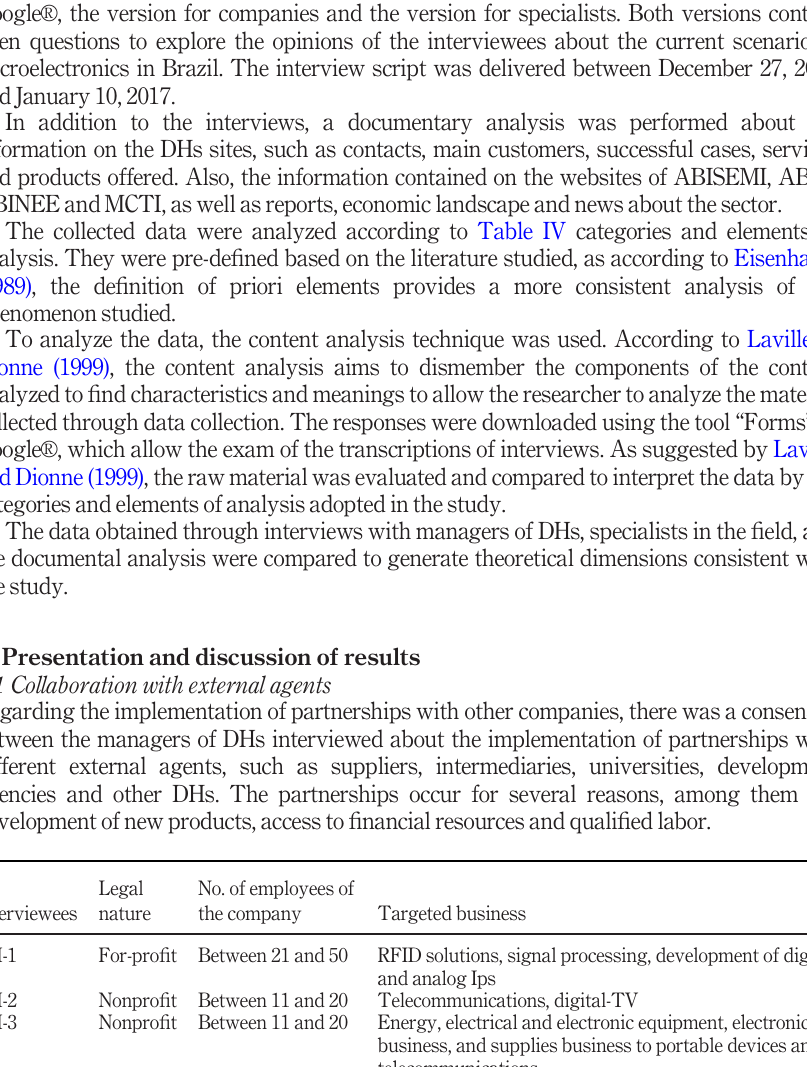
Table III. Institutional pro fi le of design houses